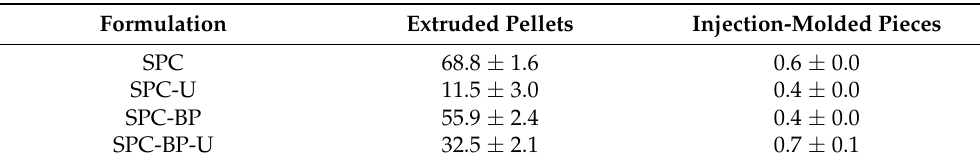
Table 3. Resistance to mechanical abrasion of the extruded pellets and the resulting injection-molded pieces (% of fines, w / w